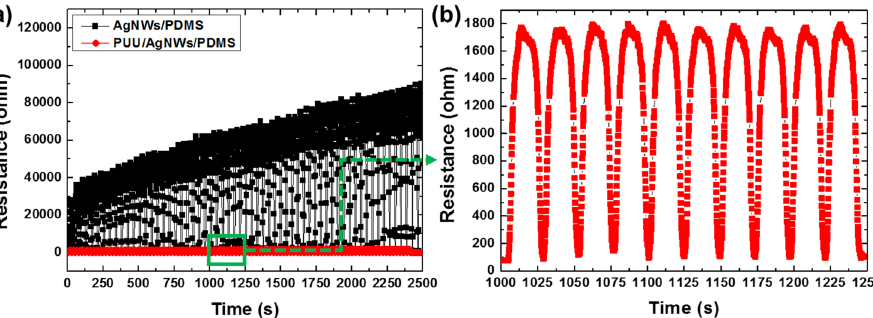
Figure 4. ( a ) Resistance variation of the AgNWs/PDMS and PUU/AgNWs/PDMS sensors measured during stretching and release (strain: 100%) cycles for up to 2500 cycles. ( b ) Show that of the PUU/AgNWs/PDMS in the time range of 1000–1250